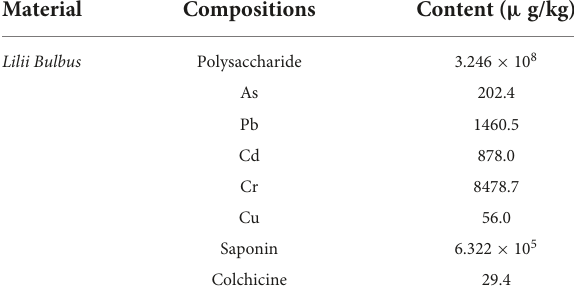
TABLE 1 Compositions and content of Lilii